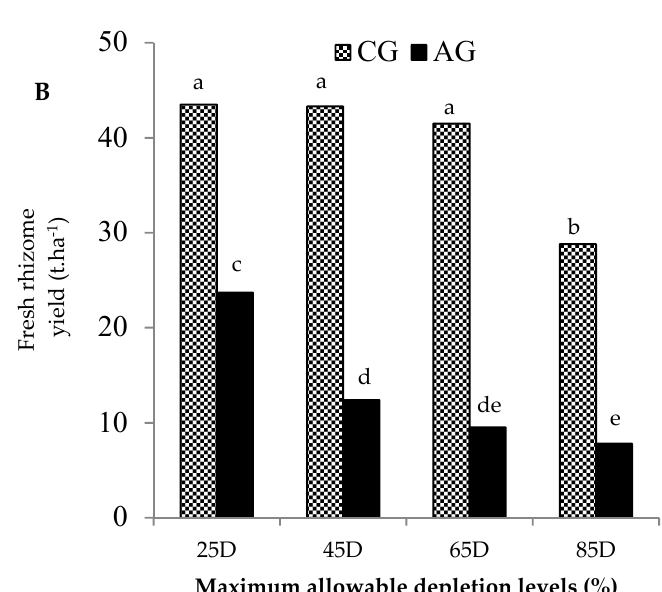
Figure 8. Fresh rhizome yield (t ha − 1 ) of African ginger in response to irrigation regimes during the ( A ) 2015/2016 and ( B ) 2016/2017 cropping seasons. Mean values followed by the same letter on the same bars are not significantly different at ( p ≤ 0.05) level according to the Tukey’s test. Where: CG: Commercial ginger; AG: African ginger; Lsd = 2.4 and 4.6 for Figure A and B respectively.